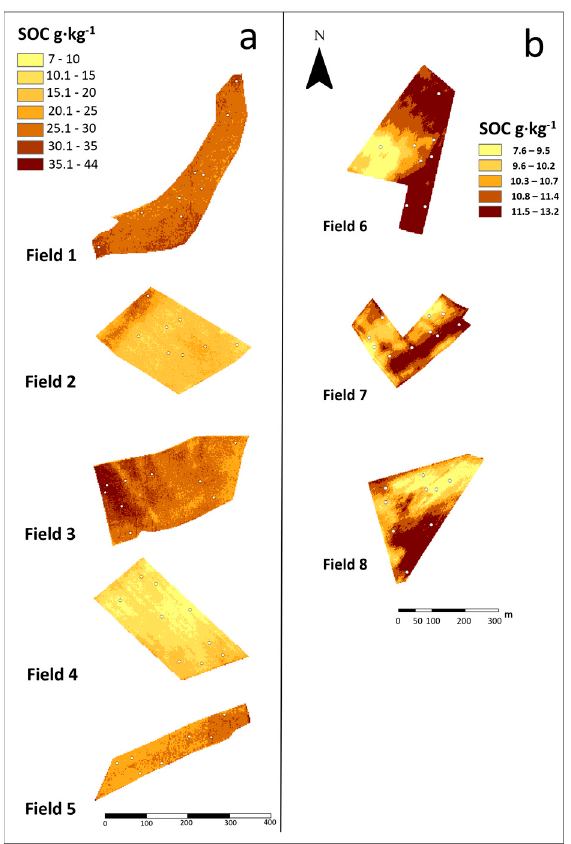
Figure 4. SOC maps of the validation fields in Luxembourg ( a ), and Belgium ( b ), using the bottom-up approach. The white points in the fields correspond to the validation dataset.